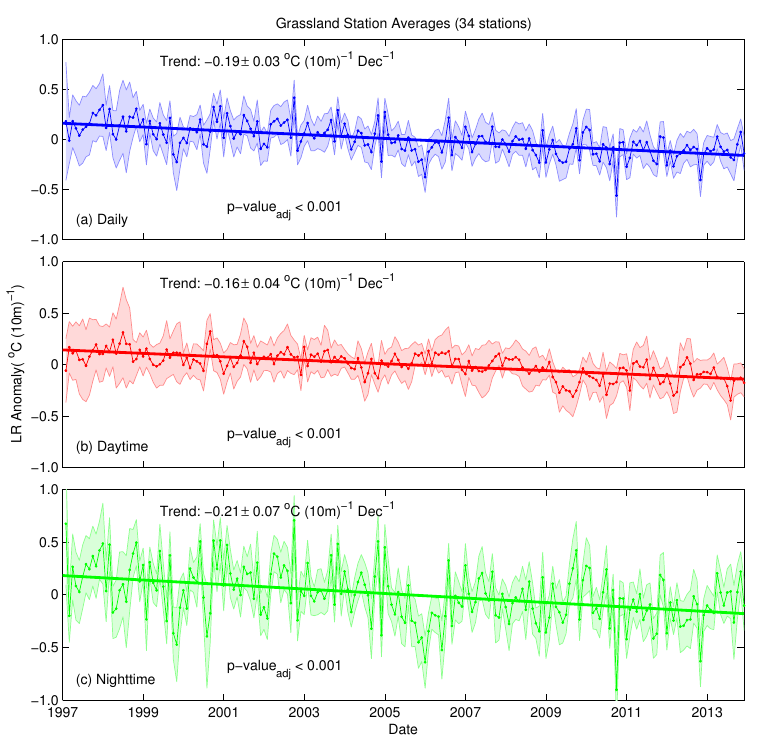
Figure 7. Changes of monthly lapse rates (LR) ( ◦ C (10m) − 1 ) averaged only by grassland stations in Oklahoma over 1997–2013: (a) daily anomaly derived from 24h averaged over two heights, (b) daytime anomaly, and (c) nighttime anomaly. The straight lines are least squares trends ( ◦ C (10m) − 1 per decade) with adjusted p values shown. The ± values define the 95% confidence intervals for trends. The shaded region shows the standard deviation from 34 grassland